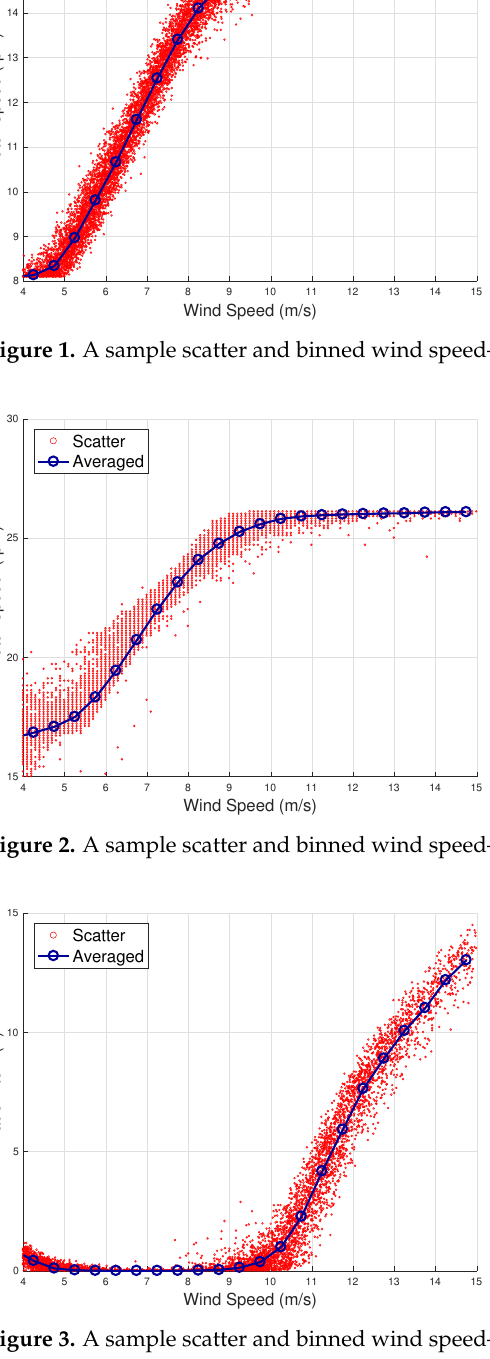
Figure 3. A sample scatter and binned wind speed–blade pitch curve for